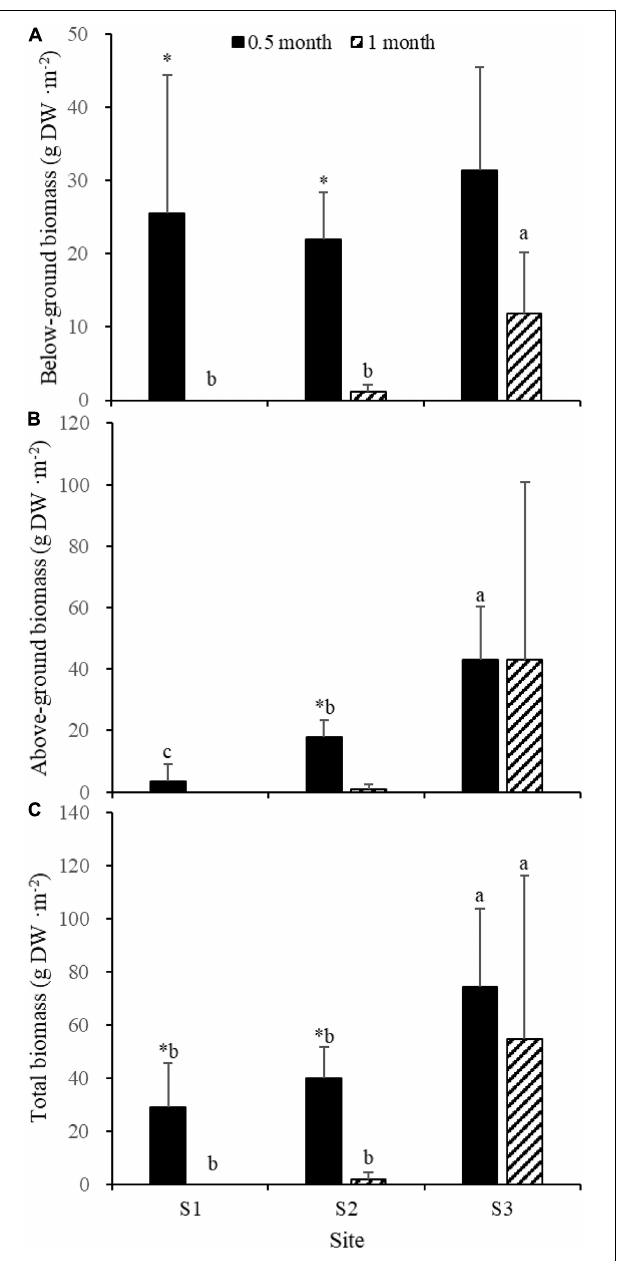
FIGURE 9 | Below-ground biomass (A) , above-ground biomass (B) , and total biomass (C) of Zostera japonica in the three transplant sites at 0.5 and 1 month after transplantation. Values are mean ± SD. ∗ Indicates significant difference between time points in the same transplant site. Different letters indicate significant difference between different transplant sites at the same time point.